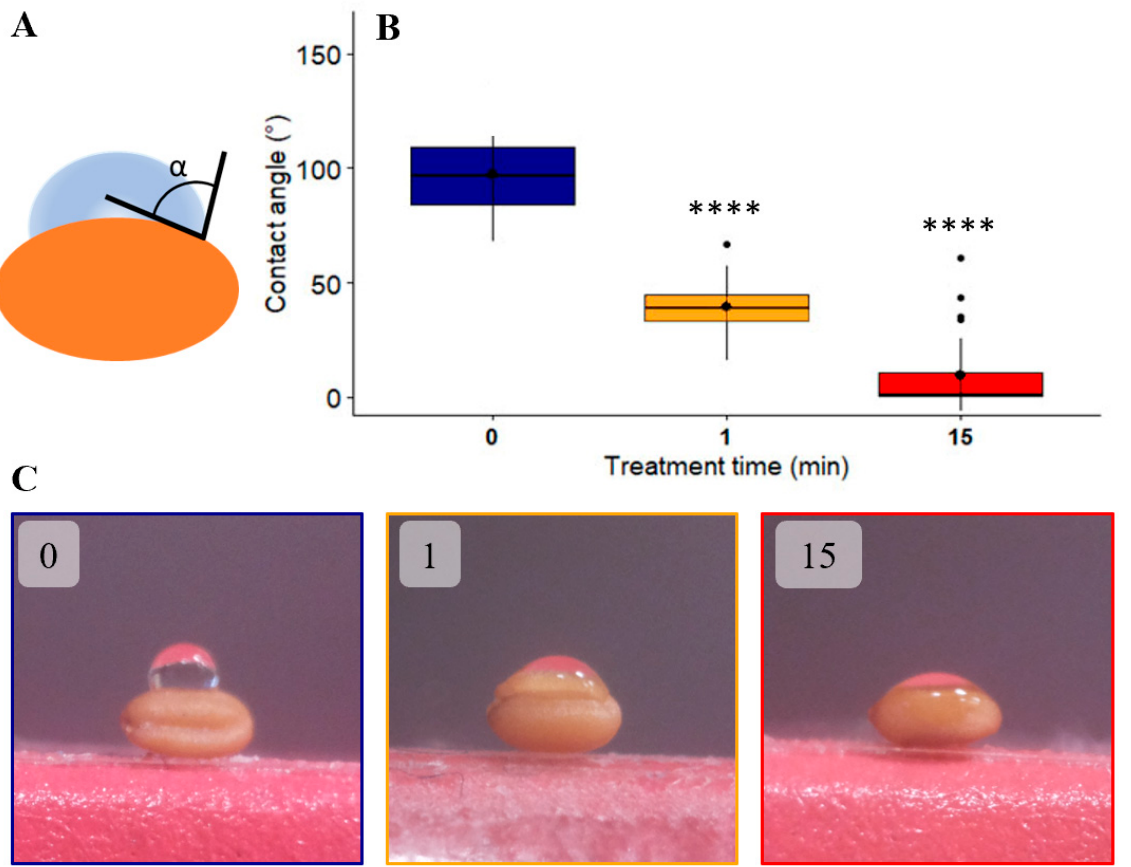
Figure 3. Contact angle assay on C. sativa seeds for different plasma treatment times. The amount of 0.3 µ L of water is dropped on the surface of the C. sativa seeds and the contact angle is measured. ( A ): The scheme of the contact angle that is measured in this experiment. ( B ): Boxplot of the measurement of contact angle versus different treatment times. The seeds were treated with DBD air plasma for 1 min (orange), 15 min (red) or non-treated (blue). ( C ): Pictures of the water droplet on seeds with or without plasma treatment. The experiment is carried out on 30 seeds from 2 different exposures for each treatment (1 min and 15 min while 0 min corresponds to the control). The significance differences were determined using the Duncan test: ****: p -value < 0.00005.